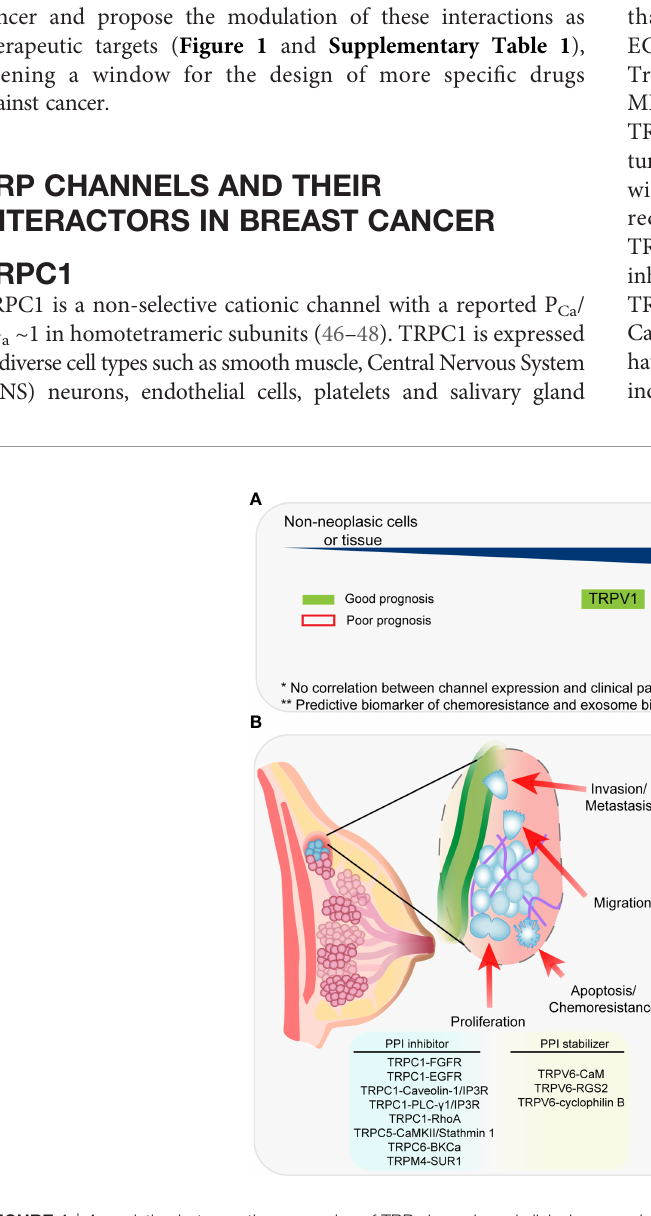
FIGURE 1 | Association between the expression of TRP channels and clinical prognosis and PPIs proposed as therapeutic targets. (A) Summary of the expression of TRPC channels in tumoral vs non-tumoral tissue and the association between TRP channels and clinical prognosis. (B) Summary of the PPIs proposed as therapeutic targets and their associated-pro-tumoral